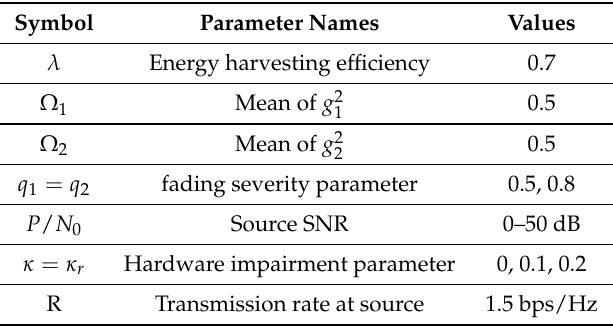
Table 1. Observed values of system parameters, 2019 IEEE